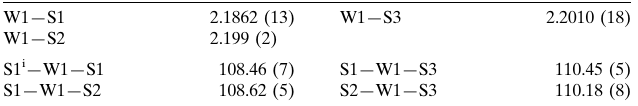
Selected geometric parameters (A˚ , (cid:3) ).